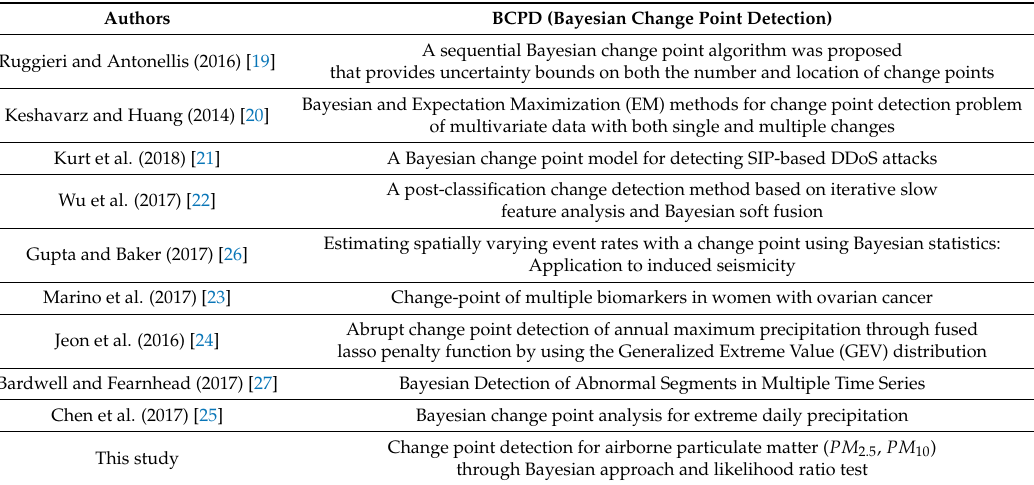
Table 3. BCPD (Bayesian change point